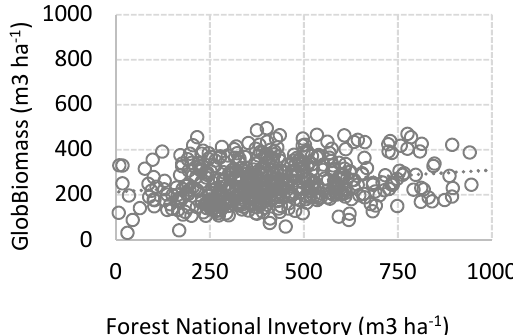
Figure 6. Growing stock volume estimated by GlobBiomass map at national forest inventory loca- tions.